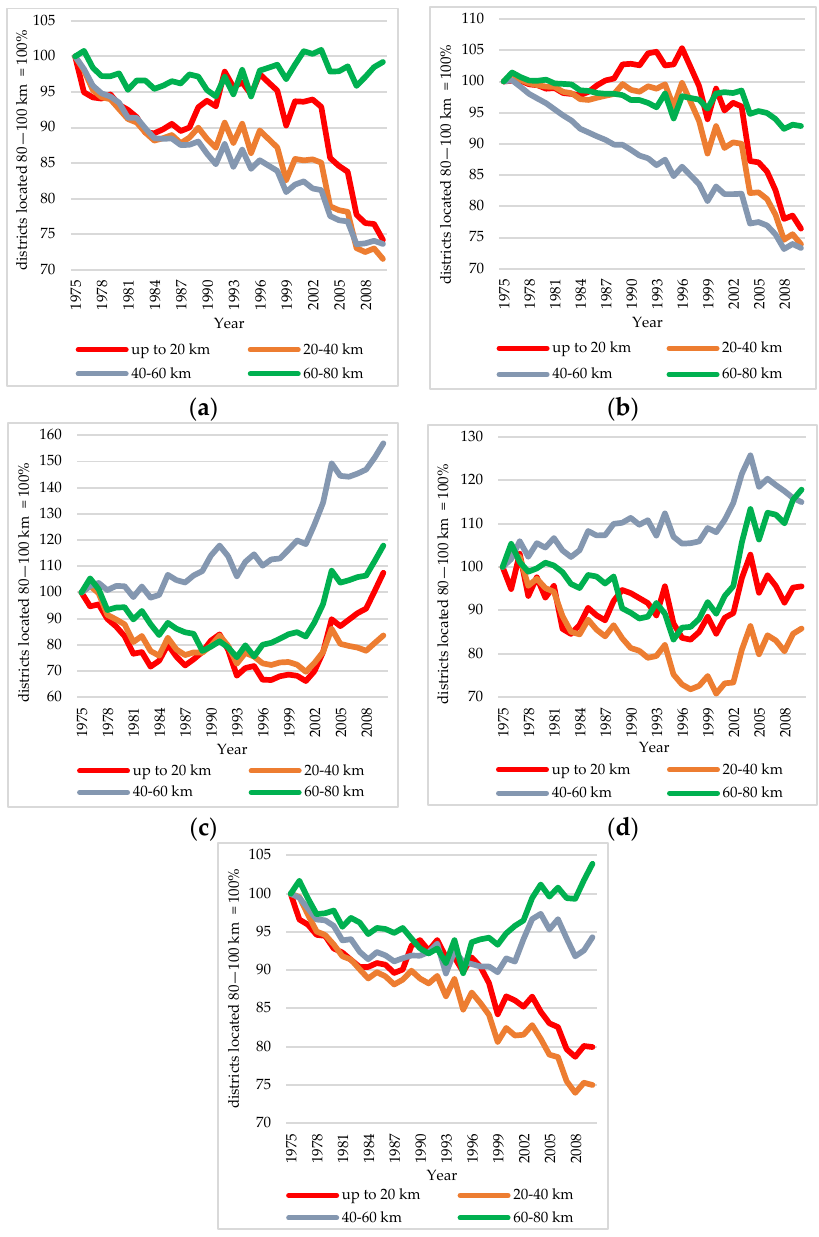
Figure 4. The dynamics of changes in the number of cattle, cows, pigs, sows and large size units in the districts depending on the distance from Bełchatów opencast mine compared to the dynamics of changes in the size of livestock in the districts located 80–100 km away from the mine: ( a ) cattle (without cows); ( b ) cows; ( c ) pigs (without sows); ( d ) sows; ( e ) LSU. Source: based on [50,58].